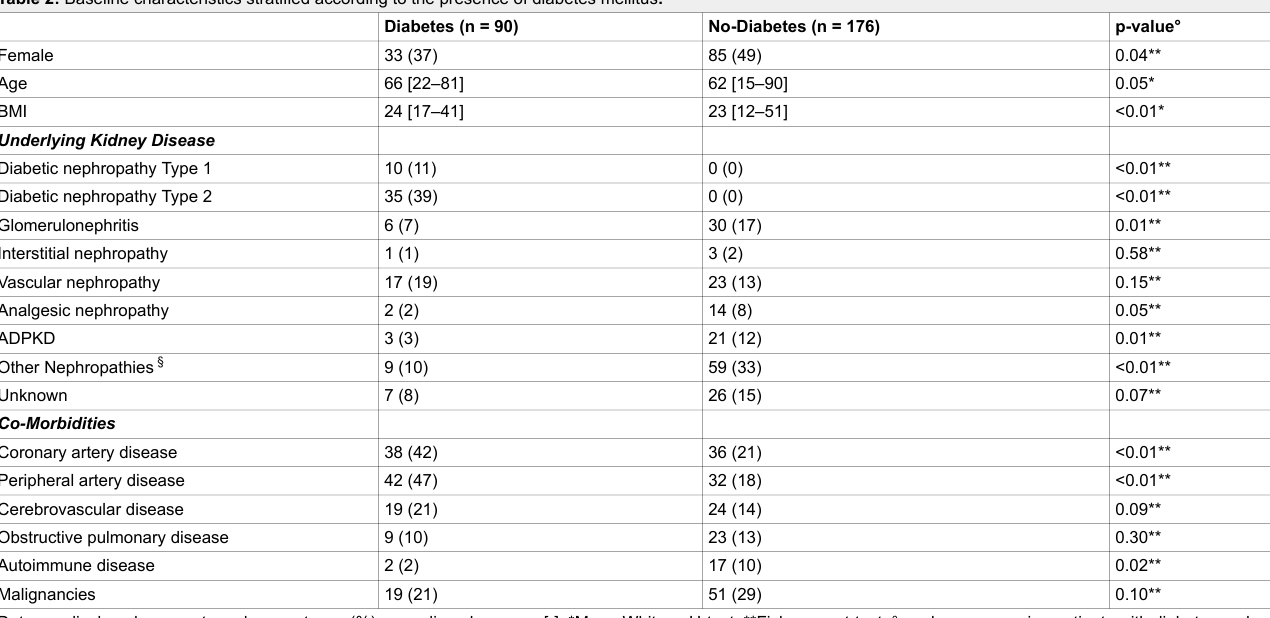
Table 2: Baseline characteristics stratified according to the presence of diabetes mellitus